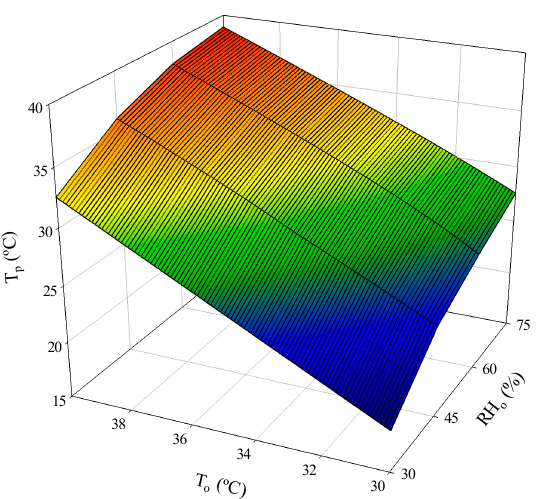
Figure 8. Evolution of the air temperature when exiting the pad (T p , °C) as a function of the exterior temperature (T, °C) and relative humidity (RH, %) values.